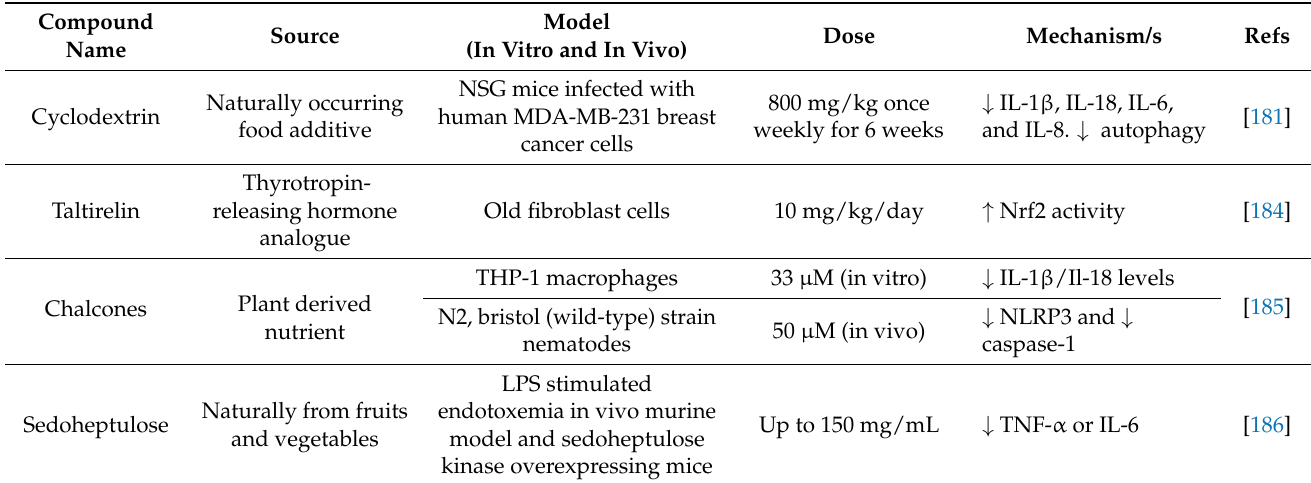
Table 3. List of selected nutrient compounds with patent claims targeting